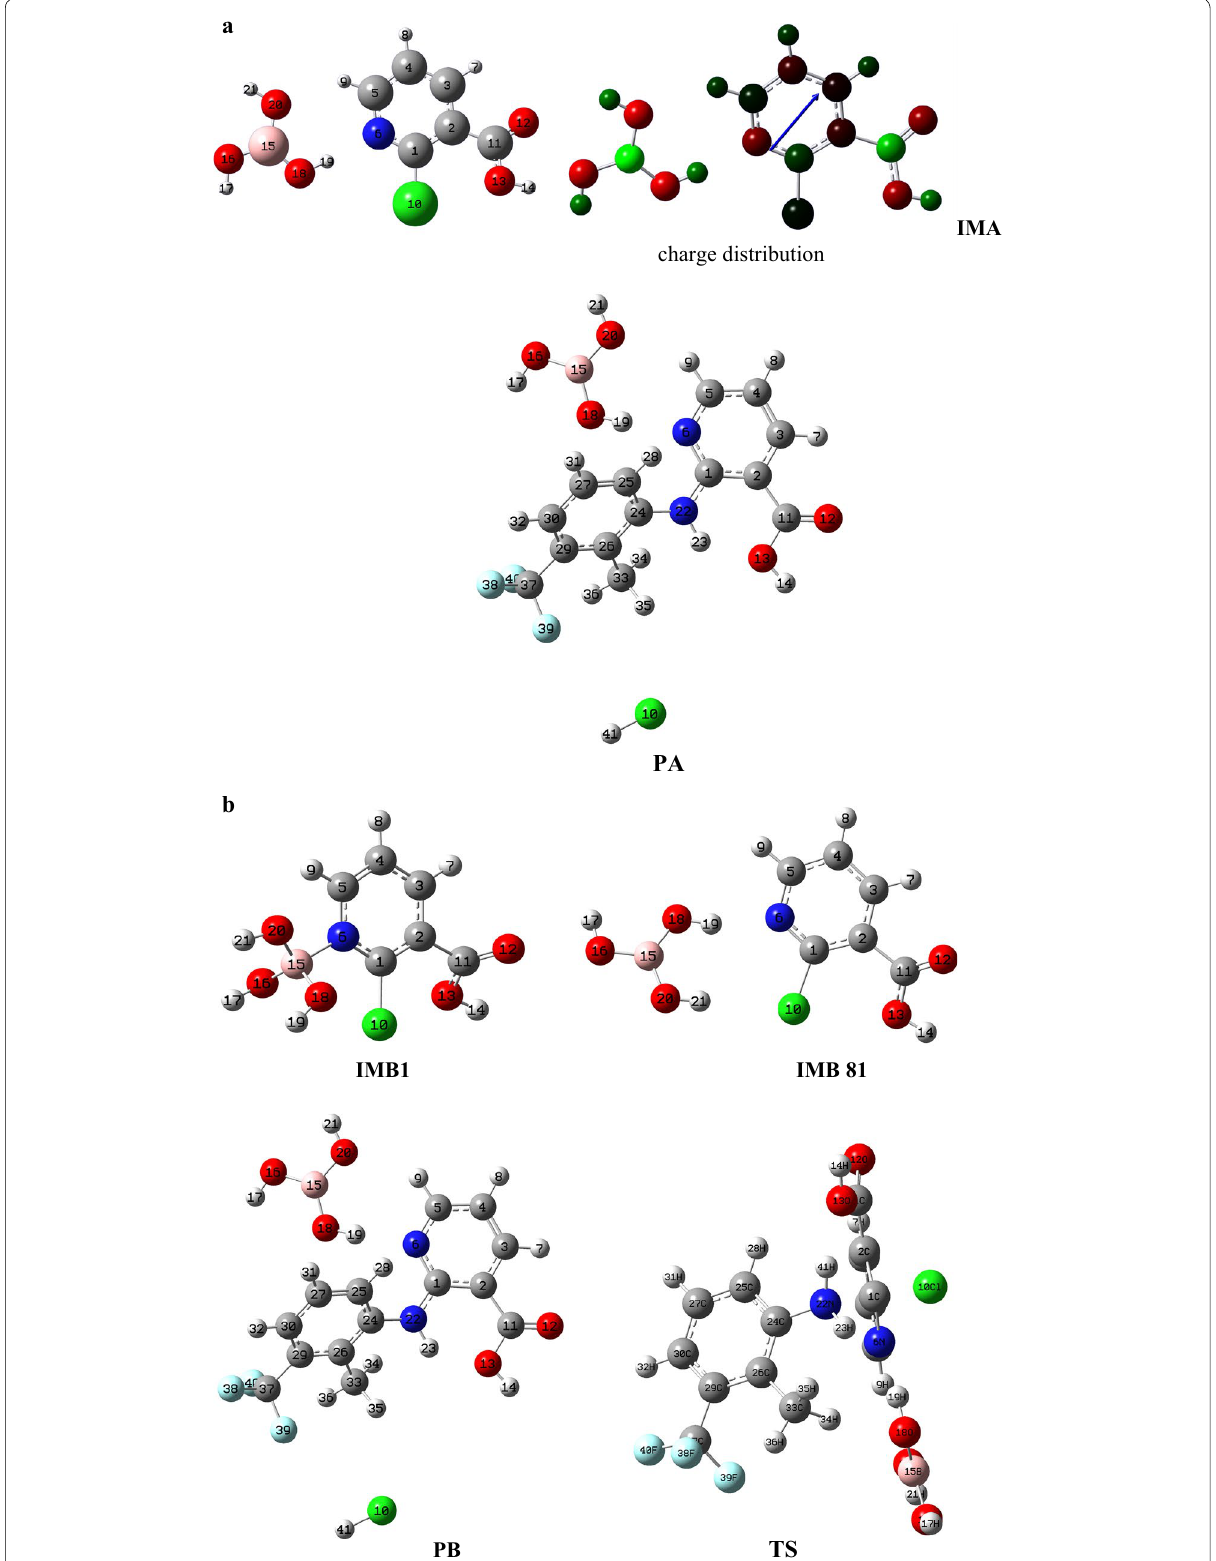
Fig. 4 The optimized structures of nicotinic acid-boric acid, IMs, and product for pathway ( a , b ) by B3lyp/6-311G (d, p) singlet in the gas